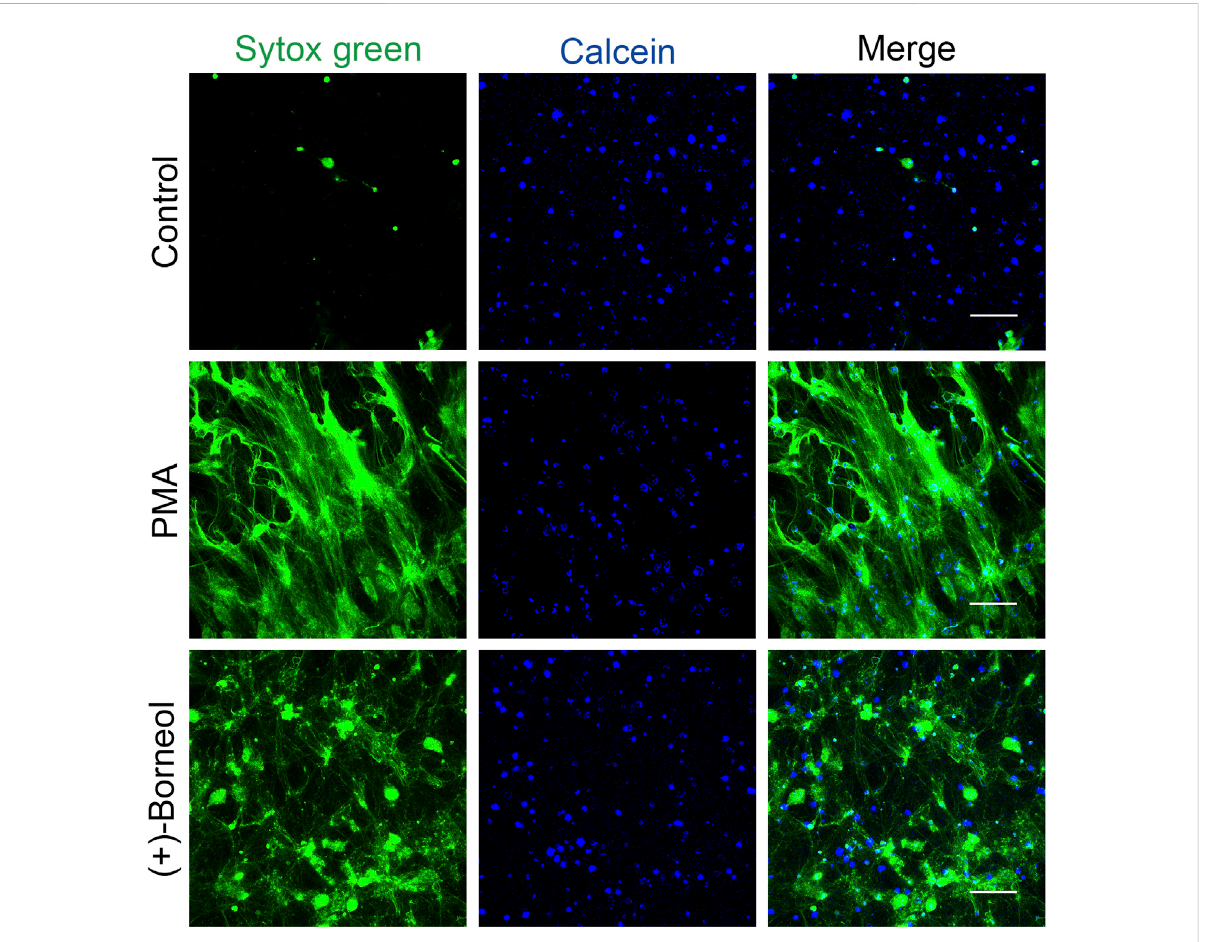
FIGURE 3 Immunostainingcon fi rmstheeffectof(+)-borneolonNETosis.Neutrophilsthathadnotreatmentorstimulationweresetascontrol.InthePMA group, neutrophils were stimulated with PMA for 4 h. In the (+)-borneol group, neutrophils were preincubated with 400- μ M (+)-borneol for 30 min before 100-nM PMA stimulation. We visualized live neutrophils and NETs with Calcein Blue AM (blue) and SYTOX Green nucleic acid stain (green), respectively. Scale bars: 100 μ m ( n =